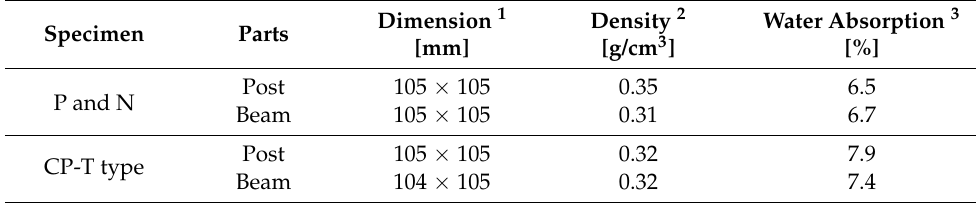
Table 1. Density and water absorption of the timbers for the pullout test specimens. Specimen